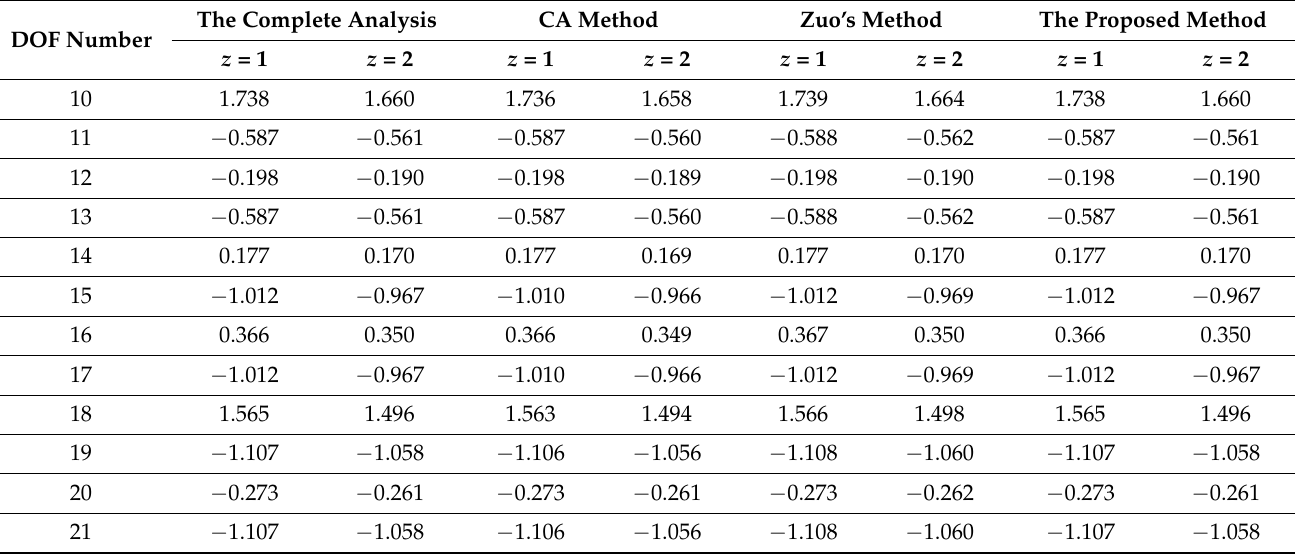
Table 8. Displacement sensitivities for modification type 2 when z = 1 and z = 2 ( × 10 − 5 ).